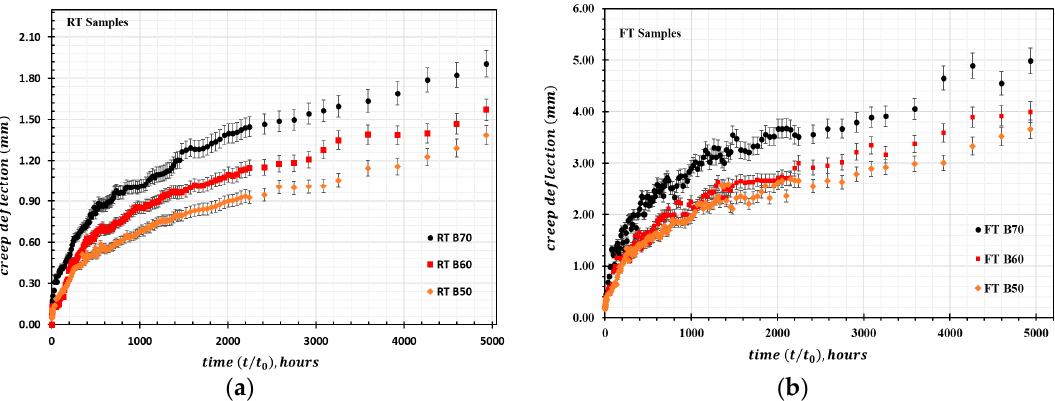
Figure 7. HFRP creep deflection for samples loaded at 50–70% ultimate stress: ( a ) Creep deflection for untreated RT samples; ( b ) Creep deflection for freeze–thaw pretreated FT samples.